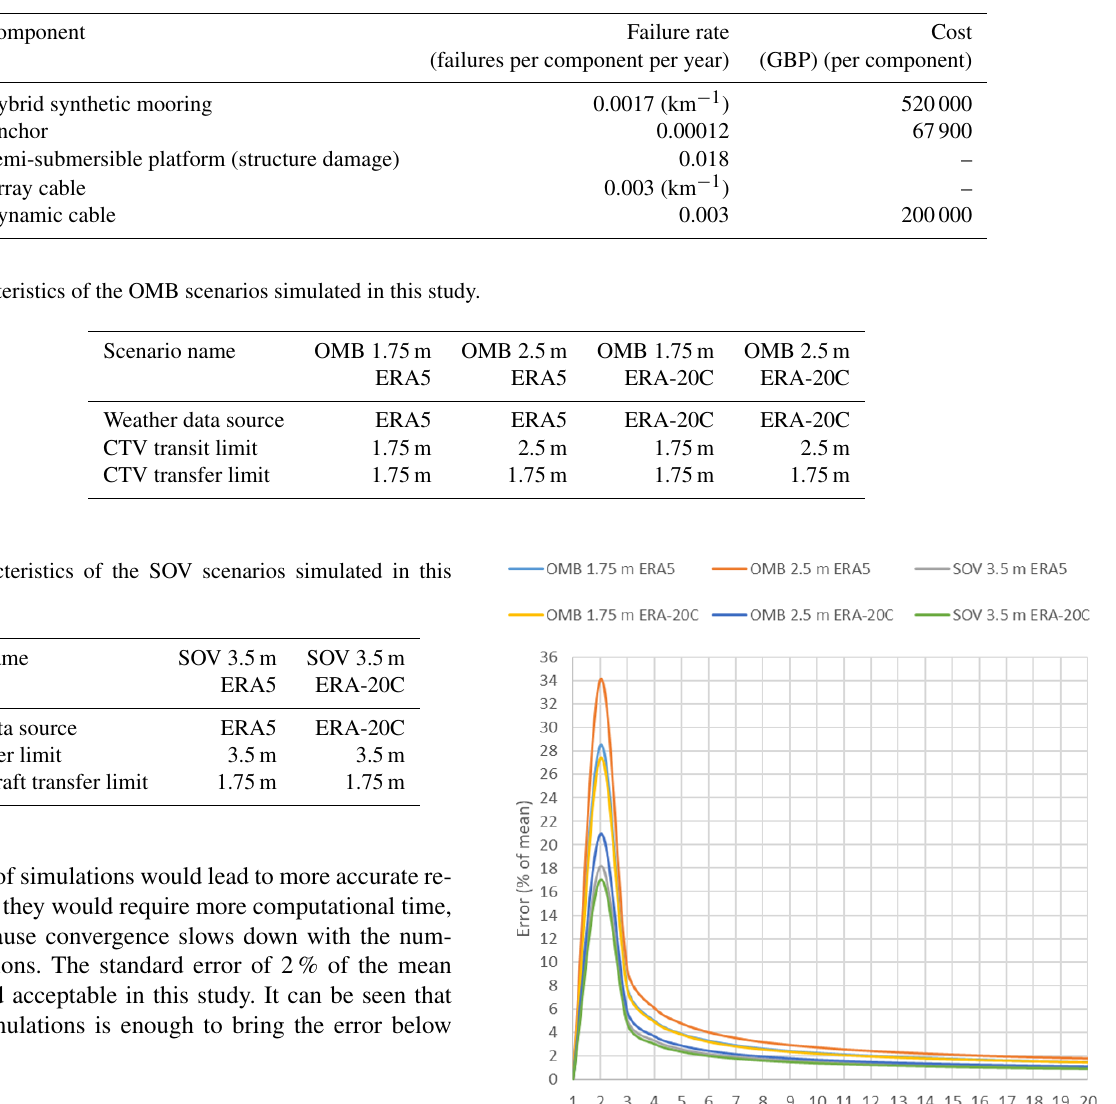
Table 2. Failure rates and replacement costs of floating wind turbine subsea components assumed for this study.